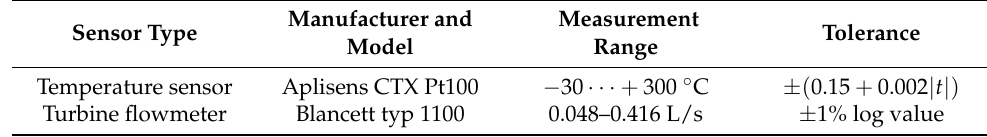
Table 2. Characteristics of the measurement sensors used in the